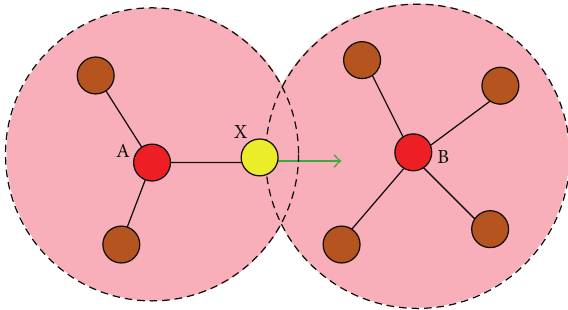
Figure 1: Mobile node X moving from cluster A to cluster B.